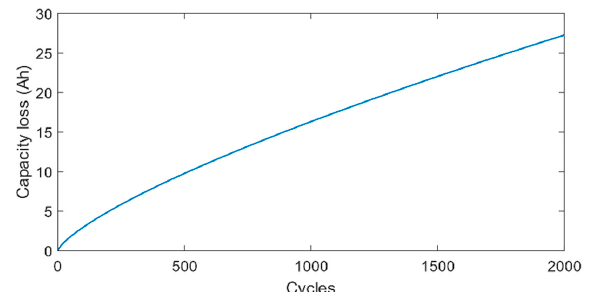
Figure 9. Desirable ageing trajectory for the BESS.